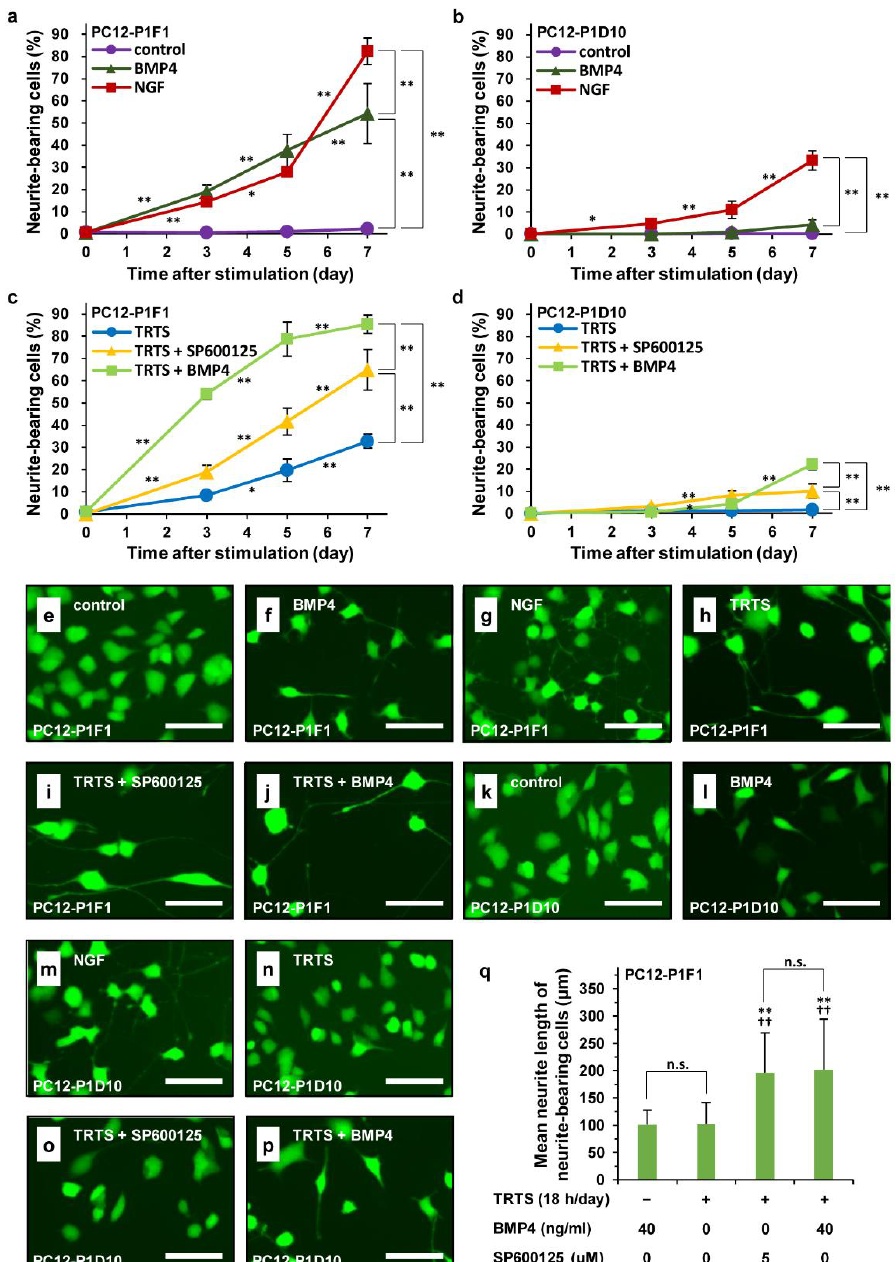
Figure 3. Time course and live imaging of SP600125-mediated enhancement of TRTS-induced neuritogenesis in PC12-P1F1 cells. PC12-P1F1 or PC12-P1D10 cells were incubated with BMP4 (40 ng/mL) or NGF (50 ng/mL) for 7 days. Furthermore, PC12-P1F1 or PC12-P1D10 cells were also pretreated with SP600125 (5.0 μM) or BMP4 (40 ng /mL) with TRTS 18 h/day for 7 days. PC12-P1F1 ( a , c ) and PC12-P1D10 cells ( b , d ) were scored for neurite outgrowth after 0 – 7 days of incubation with the indicated conditions. ( a – d ) The data represent the means ± standard deviation of four replicates. * p < 0.05; ** p < 0.01. ( e – j ) Representative live images of PC12-P1F1 cells treated without stimuli (a control) ( e ), BMP4 alone, ( f ), NGF alone ( g ), TRTS alone ( h ), TRTS plus SP600125 ( i ), and TRTS plus BMP4 ( j ). ( k – p ) Representative live cell images of PC12-P1D10 cells treated without stimuli (a control) ( k ), BMP4 alone, ( l ), NGF alone ( m ), TRTS alone ( n ), TRTS plus SP600125 ( o ), and TRTS plus BMP4 ( p ). ( e – p ) Scar bars: 100 μm. ( q ) The averaged neurite length of neurite-bearing PC12-P1F1 cells 7 days after the indicated stimulations. The data represent the means ± standard deviation of ten replicates. †† p < 0.01 vs. BMP alone; ** p < 0.01 vs. TRTS alone; n.s., not significant.